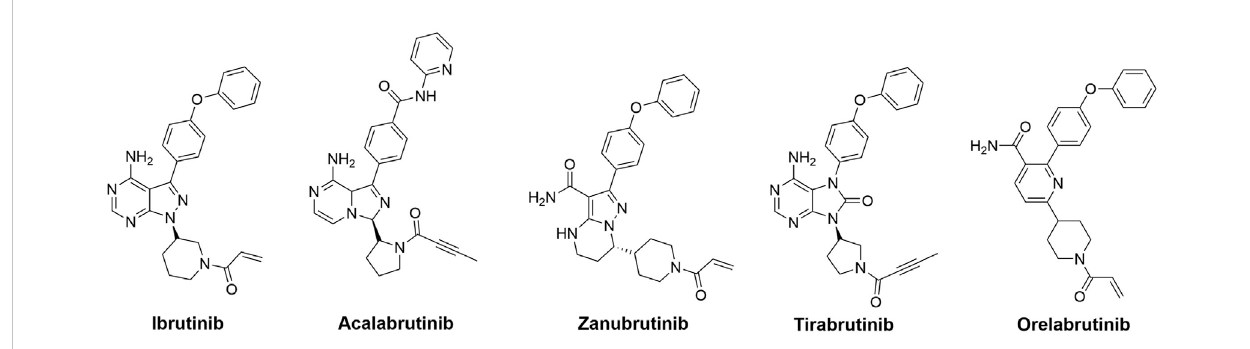
FIGURE 1 Representative BTK inhibitors on market.